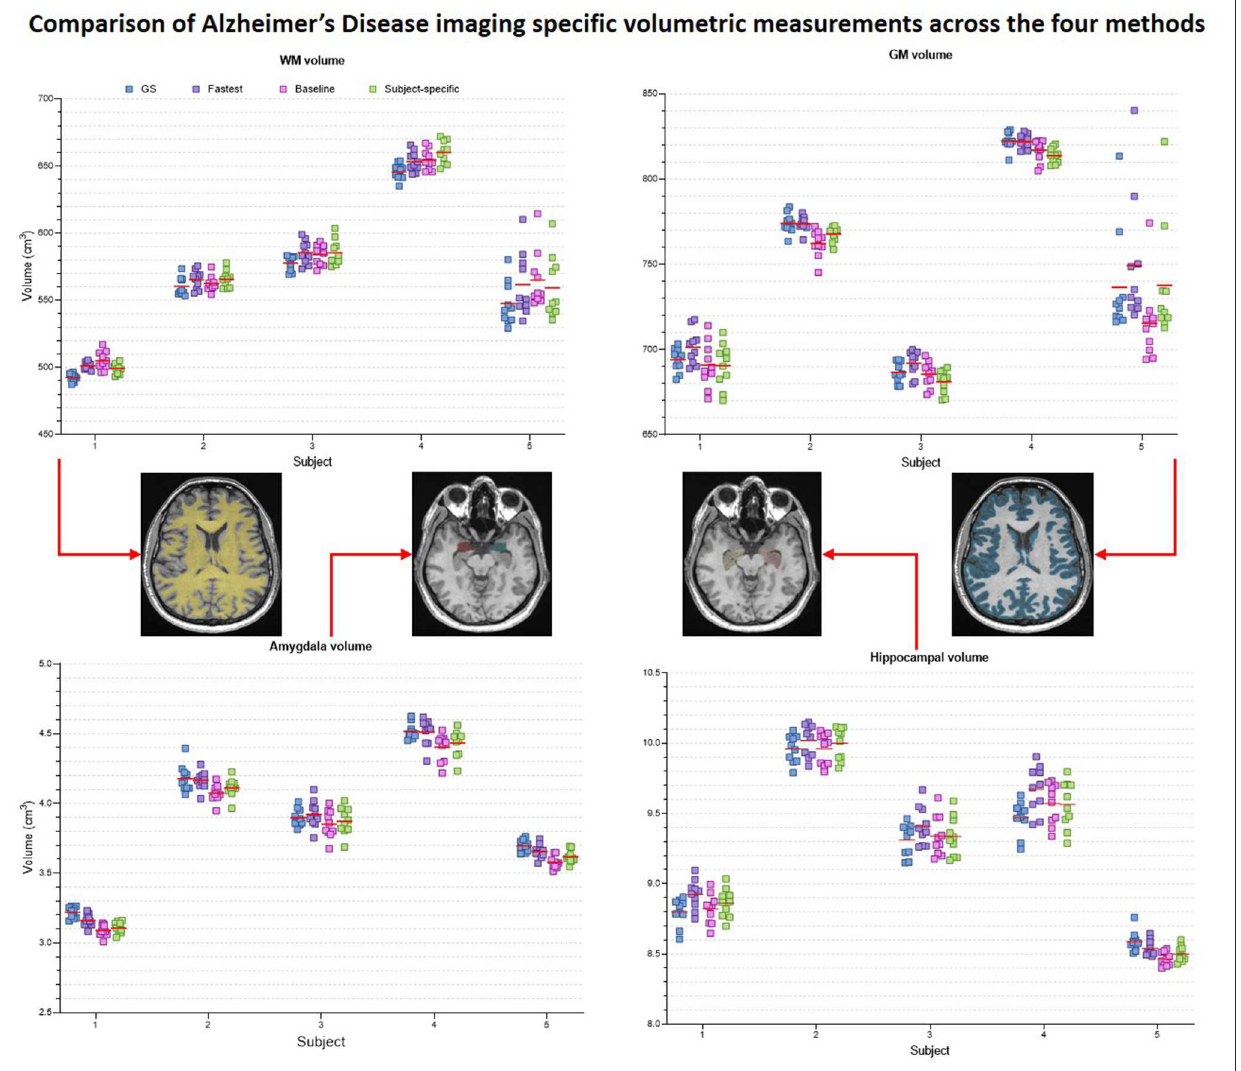
FIGURE9 Volumetric measures of White Matter (WM), Gray Matter (GM), Amygdala and Hippocampus obtained from baseline deep learning and subject-specific deep learning (SS) denoising methods. Values across all 5 repeats are reported. Inset: Representative tissue, lobes and subregions